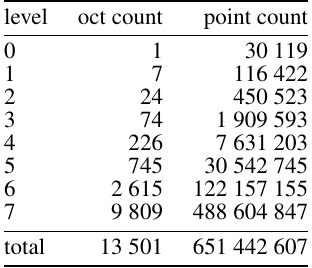
Table 5. Statistics on the octree layout, which we